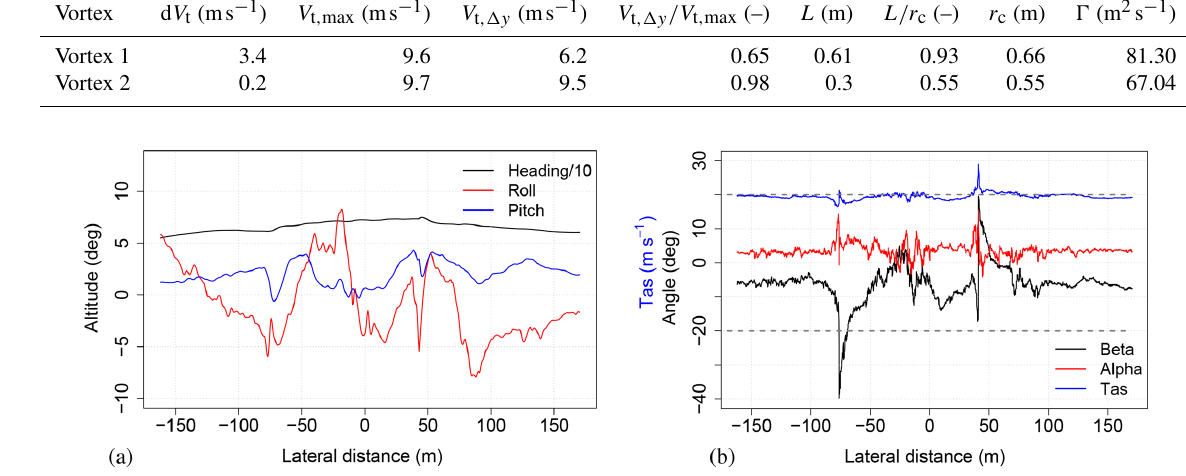
Figure 15. (a) Attitude angles of the UAS from flight leg taken for the tip vortex evaluation. (b) Angle of attack (alpha) and sideslip (beta) at the five-hole probe. Dashed grey lines indicate the calibration range of the five-hole probe. Overstepped angles are extrapolated in post-processing. In blue is the true air speed of the UAS.